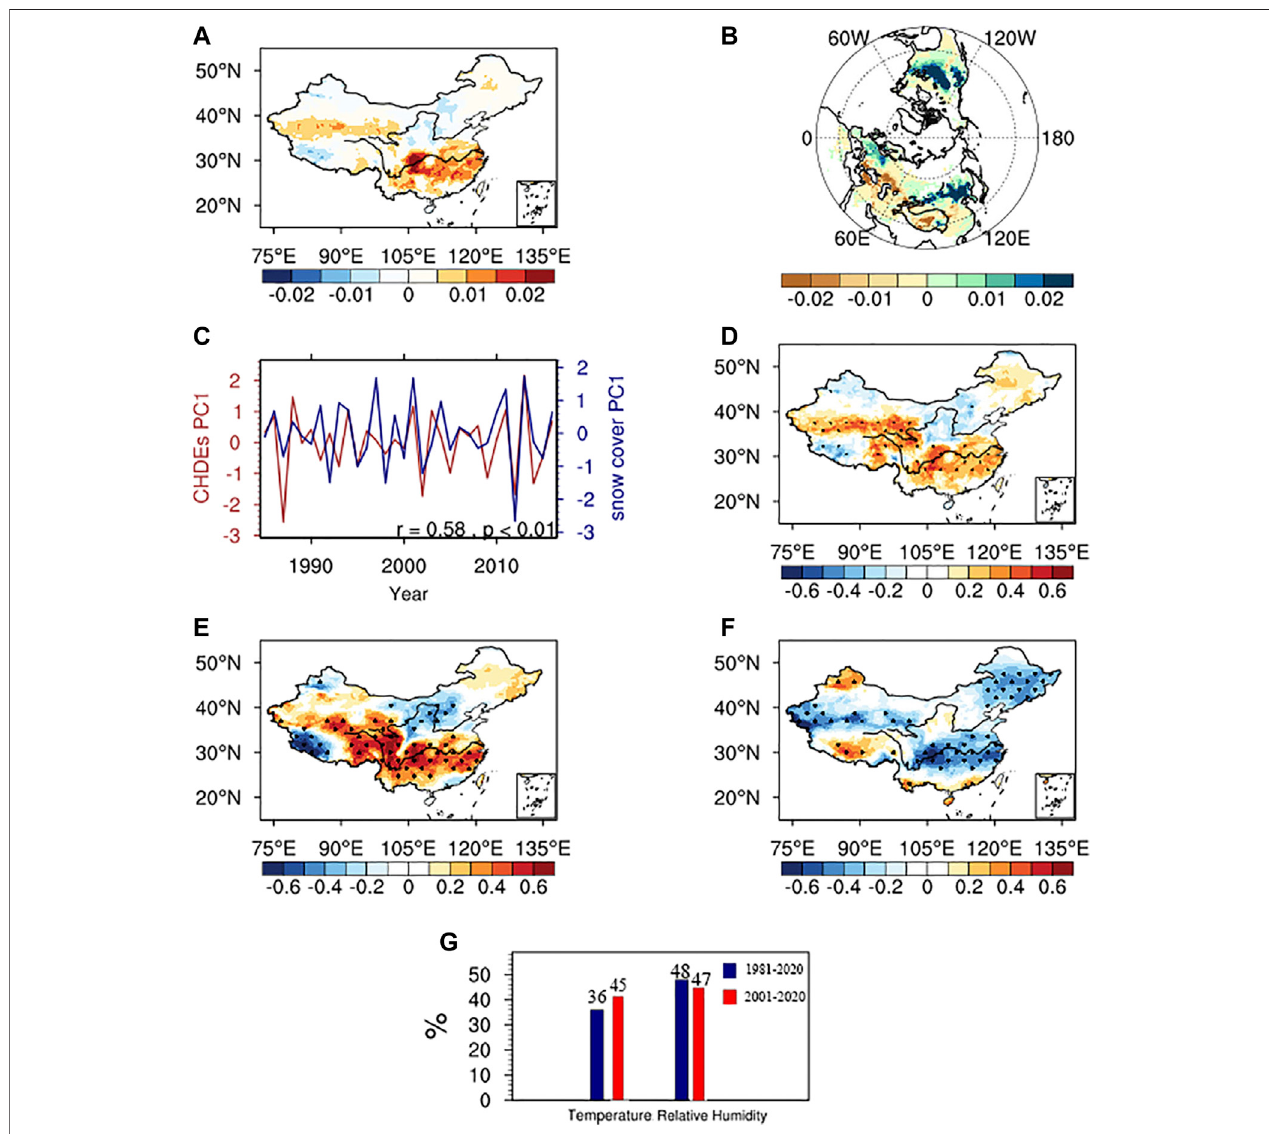
FIGURE3|(A) TheEOF1ofsummerCHDEsinChinaduring1981 – 2020. (B) TheEOF1ofwintersnowcoverintheNHduring1981 – 2020. (C) ThePC1ofsummer CHDEs(redline)andwintersnowcover(blueline)intheNH. (D) Correlationcoef fi cientsbetweenthePC1ofwintersnowcoverandsummerCHDEs.Blackdotsindicate values signi fi cant at the 95% con fi dence level. Correlation maps between the PC1 of CHDEs and (E) temperature and (F) humidity fi elds during 1981 – 2020. (G) Contribution ratios of temperature and humidity to the CHDEs in the YHRB during 1981 – 2020 and during 2001 – 2020 based on a regression of area-averaged variable over the YHRB (marked by a box in A) against the PC1 of